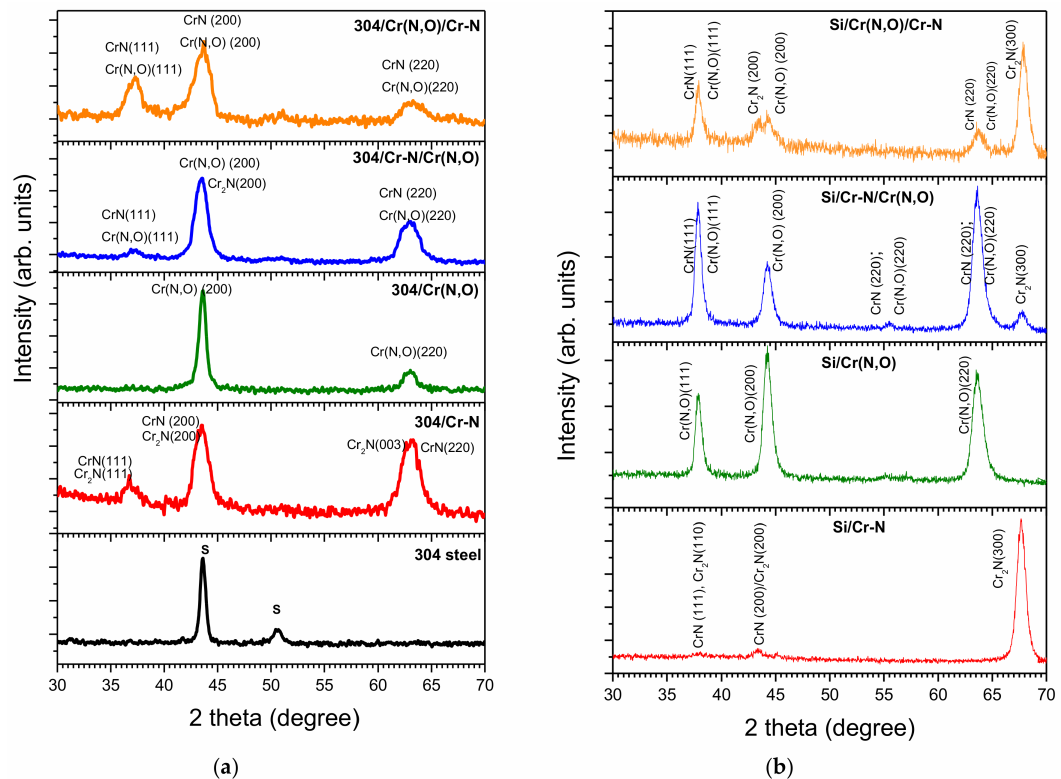
Figure 2. Grazing incidence X-ray diffraction (GI-XRD) patterns of the Cr–N and Cr(N,O) coatings: ( a ) deposited on stainless steel (SS); ( b ) deposited on Si.